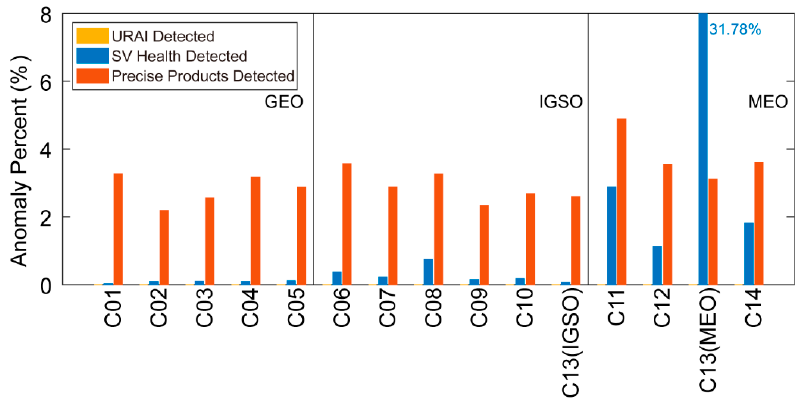
Figure 5. Comparison of the URAI, SV health, and the precise product anomaly detection